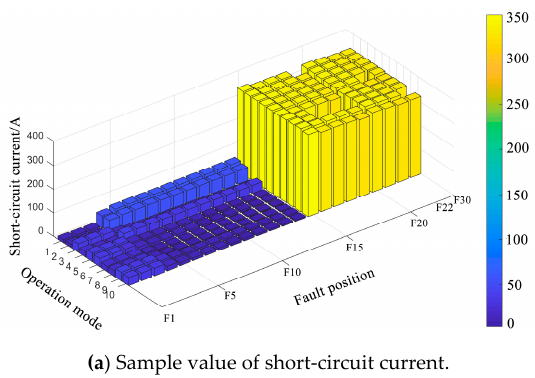
Table 2. Prediction results on the test